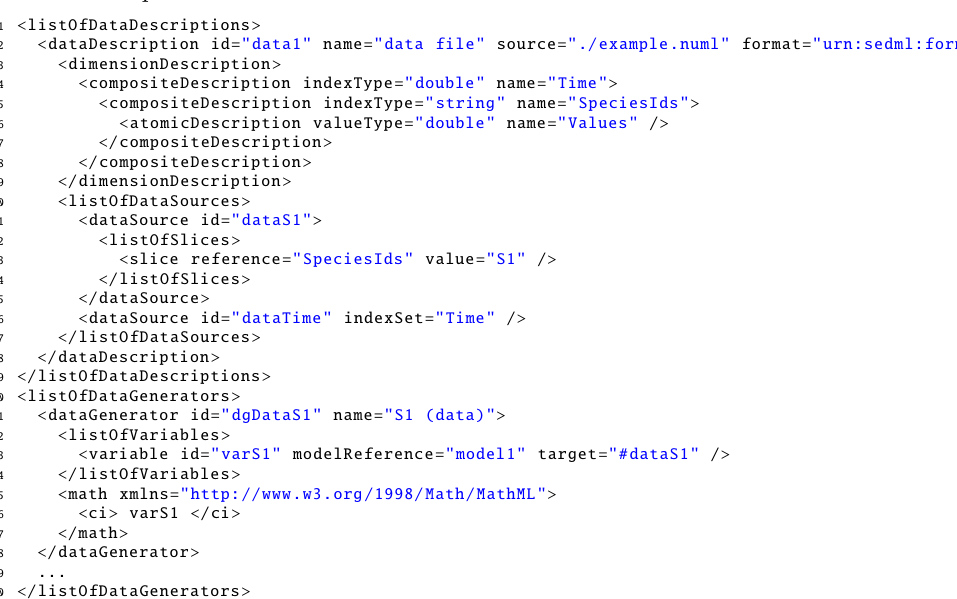
DataSource elements can be used anywhere in the SED-ML Description. Specifically their id attribute can be referenced within the listOfVariables of DataGenerator, ComputeChange or SetValue objects. Here an example that references the DataSource dataS1